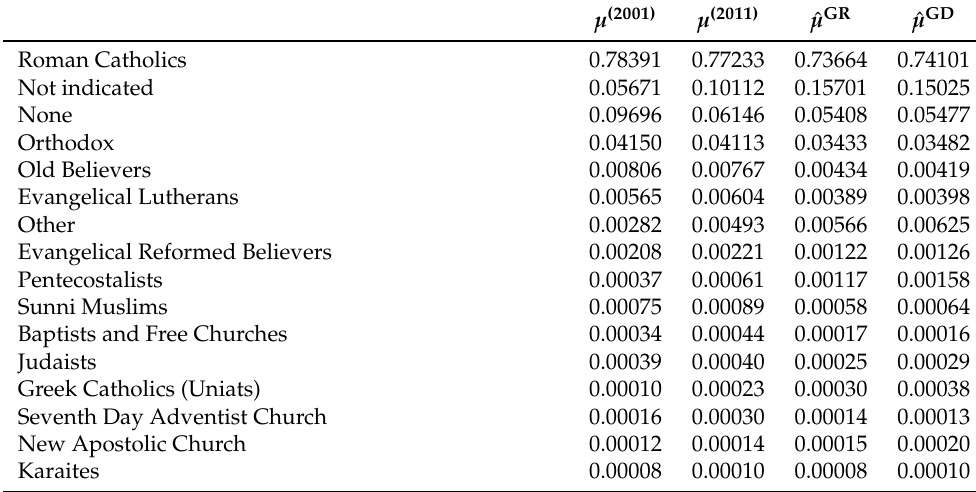
Table 3. Religion proportions in 2001, 2011, and 2021 census